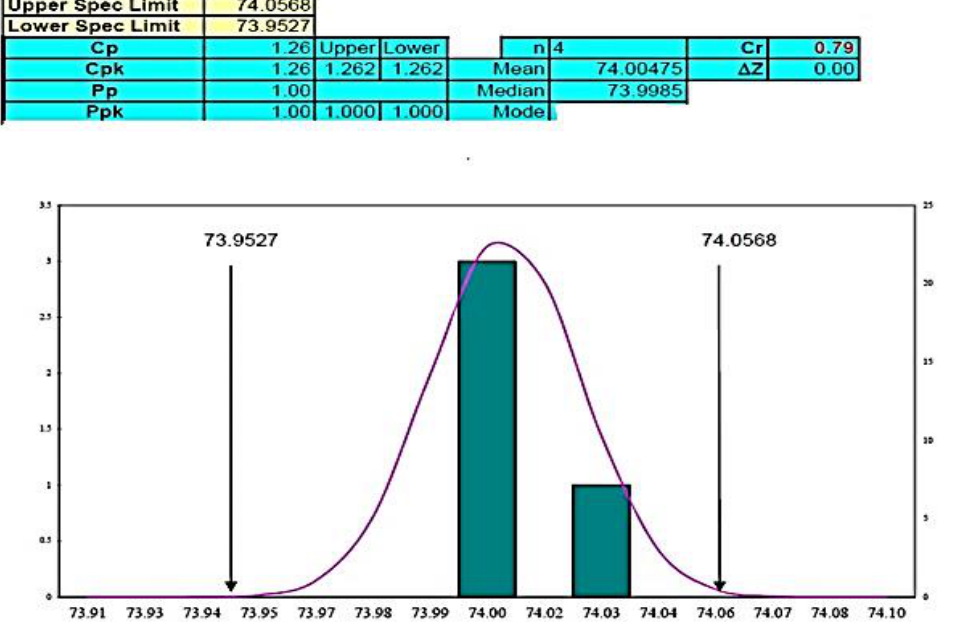
Fig. 22. Chart of capability for the reception time.